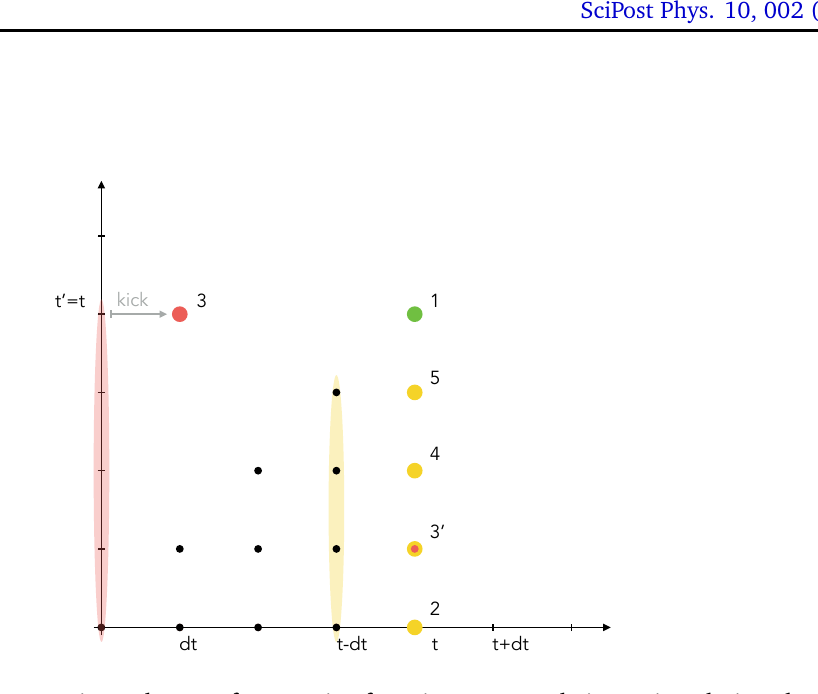
Figure 9: Integration scheme of two point functions proceeds imposing their values on the diagonal (green circle) to be 1 for correlation and 0 for response, and obtaining c ( t , t (cid:48) ) and r ( t , t (cid:48) ) (yellow circles) from the integration of the functions at t − dt (shaded yellow area). Including the initial kick in the integration for c ( t , dt ) (red dot) deserves a particular treatment. It is obtained by symmetry from c ( dt , t ) (red circle) which is the result of integration of the functions c ( 0, t (cid:48) ) (shaded red area) plus the contribution from the